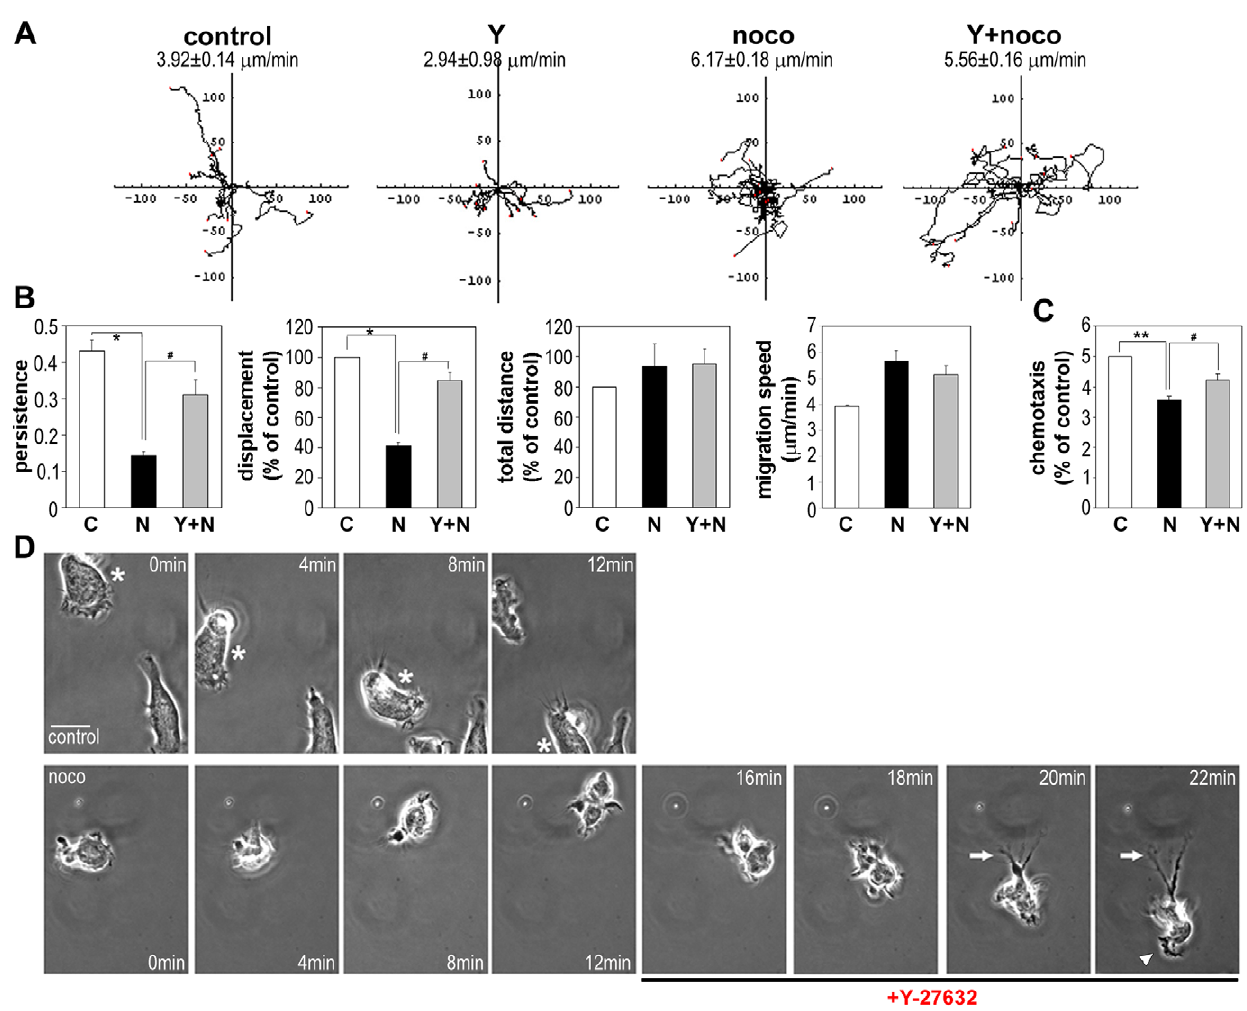
Figure 6. The effect of nocodazole on T-cell migration is rescued by Y-27632. CCRF-CEM T cells were treated with or without 10 m M Y- 27632 for 30 min and subsequently with or without 20 m M nocodazole (noco) for 10 min, then stimulated with 1 nM CXCL12 on ICAM-1-coated dishes. (A) Cell migration was monitored by time-lapse microscopy. Examples of cell trajectories of 10 to 15 cells are shown and mean migration speed 6 SEM (n=10–15). (B) Migration parameters were calculated from cell tracks. The kinetic data of 30 to 40 cells in each condition from three independent experiments are shown. *p , 0.05, compared to control cells, or # p , 0.05 compared to nocodazole-treated cells, indicated with bridges, Student’s t-test. (C) Chemotaxis of CCRF-CEM cells towards CXCL12. Cells were pre-incubated with 10 m M Y-27632 for 30 min and/or 20 m M nocodazole for the 10 min before adding to ICAM-coated transwells. Migrated cells were counted after 60 min. **p , 0.01, compared to control cells, or # p , 0.05 compared to nocodazole-treated cells, indicated with bridge, ANOVA. (D) CCRF-CEM cell migration was monitored by time-lapse microscopy. Y-27632 (10 m M) was added to nocodazole-treated cells (20 m M) (noco) at 12 min (Movie S9; bottom panels). A control migrating cell is marked with an asterisk (top panels). White arrow indicates a tail induced following Y-27632 addition; white arrowhead indicates restored lamellipodium. Bar=10 m m.